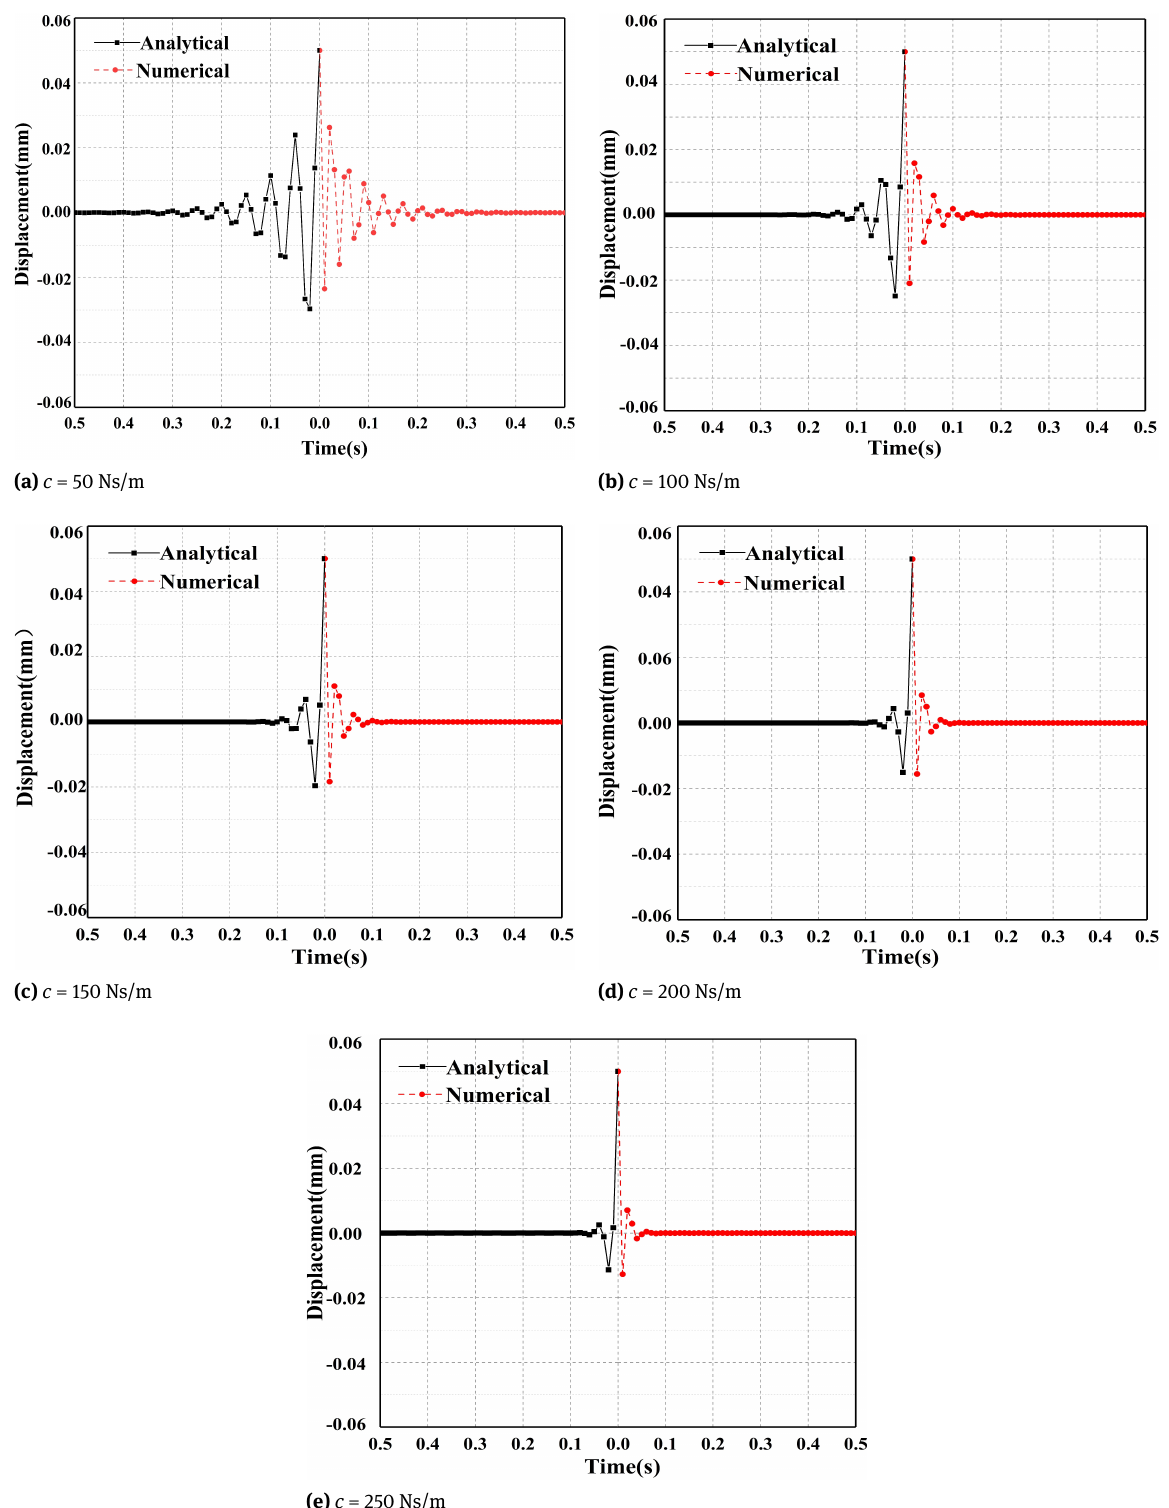
Figure 13: Displacement time history curve of the point A under different viscous